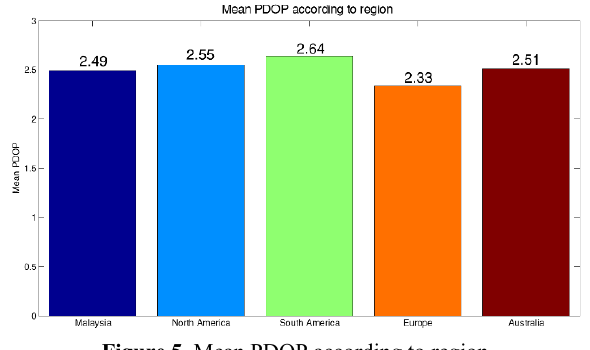
Figure 5 . Mean PDOP according to